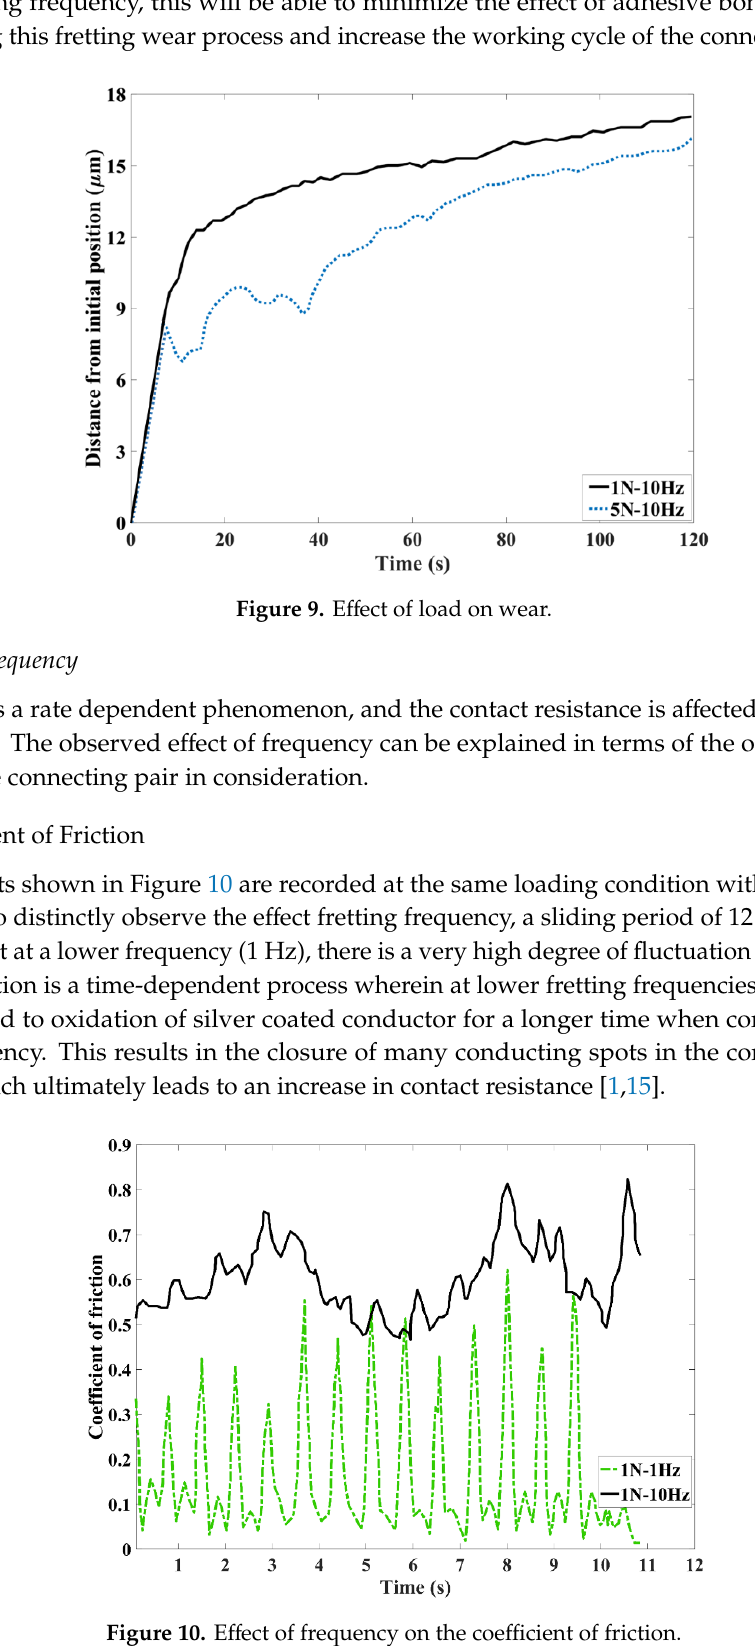
Figure 10. Effect of frequency on the coefficient of friction.